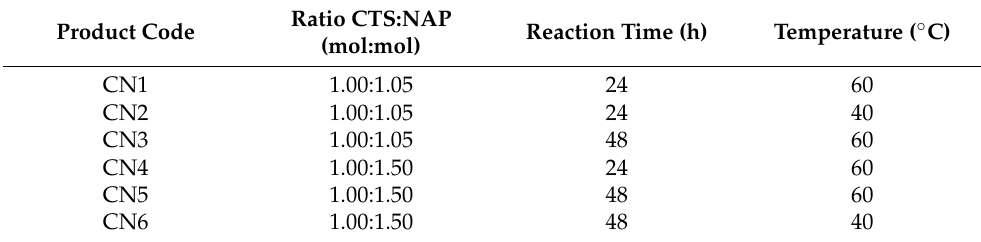
Table 1. Parameters used in the preparation of the salts.